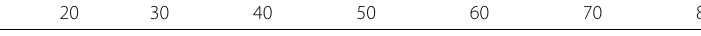
Table 4 Maximal temperature at the target point depending on variable parameter p